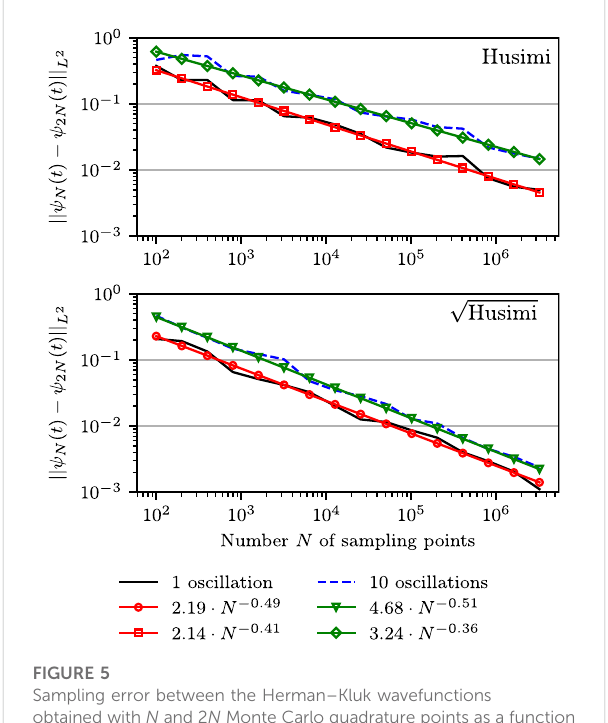
FIGURE 5 Sampling error between the Herman – Kluk wavefunctions obtained with N and 2 N Monte Carlo quadrature points as a function of N . The wavefunctions are calculated in a Morse potential with anharmonicity parameter χ = 0.005 after approximately one (solid line) or ten oscillations (dashed line). The upper panel shows both errors and their approximated convergence rates for (Case H). Similarly, (Case sqrt-H) is displayed in the lower